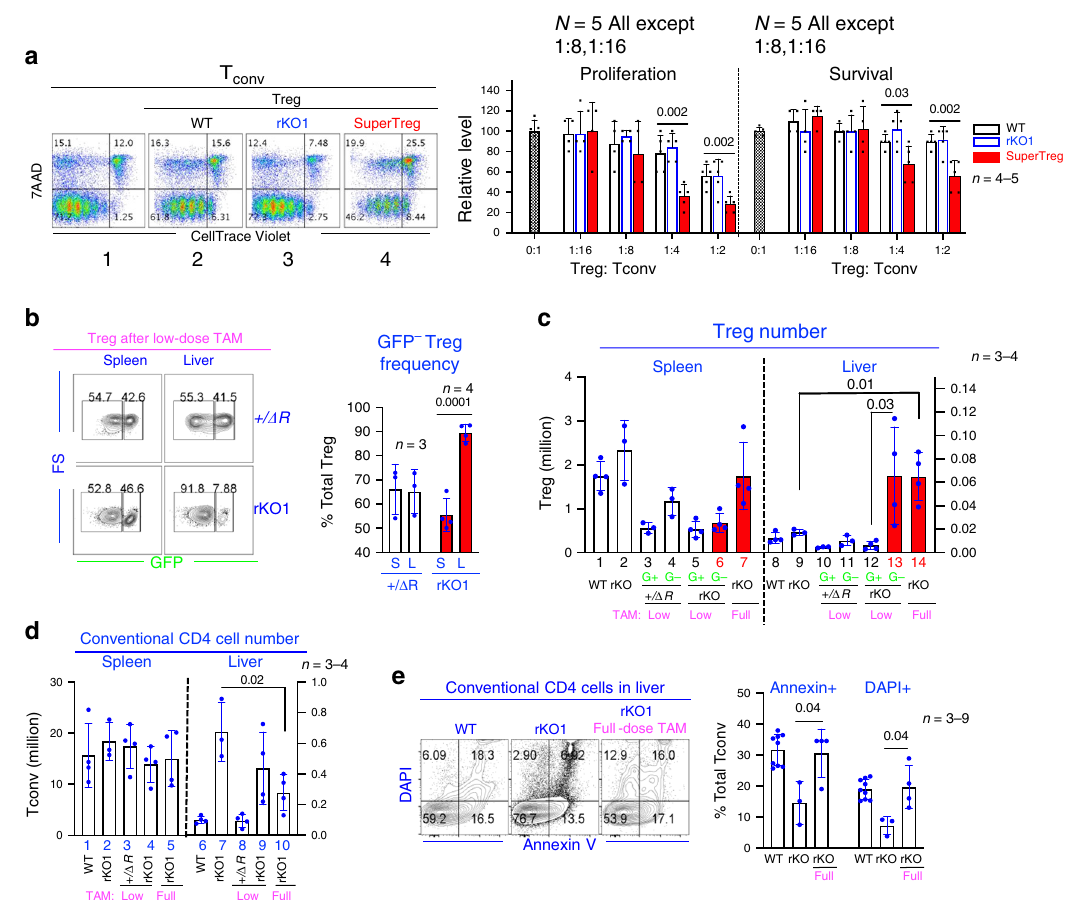
Fig. 5 SuperTreg cell function in vitro and in vivo. a SuperTreg suppression in vitro. Conventional CD4 cells (Tconv), labeled with CellTracer, were stimulated with APC and anti-CD3 in the presence or absence of Tregs for 5 days before analyzing 7-AAD and CellTracer fl uorescence. Representative FACS plots were shown at the left (Treg:Tconv = 1:4). The inverse of CellTracer MFIin total Tconv and the proportions of viable (7-AAD − ) Tconv were taken as measures of Tconv proliferation and survival, respectively, which are displayed as the percentages of the control (Treg:Tconv = 0:1). n = 5 repeats for all the conditions, except 1:16 and 1:8 ( n = 4); the data are pooled from four independent experiments. b , c SuperTreg accumulation in the liver. rKO1 mice were treated with TAM and analyzed 7 days later for Treg frequency ( b ) and number ( c ) in the spleen (S) and liver (L). In b low-dose TAM was used, leading to GFP loss in only a fraction of Tregs, as shown in the FACS plot and summarized in the bar graph. + / Δ R controls were Brg1 + / Δ R ;FoxP3 YFP − Cre ; R26 CAG-FlpoER . “ WT ” mice included + / Δ R and + / F mice as mentioned in Fig. 2a legend. G + and G − , GFP + and GFP − Treg subsets, respectively. In c n = 4 for all mice, except rKO and + /DR ( n = 3). d , e The number ( d ) and death ( e ) of conventional CD4 cells. The bar graph in e summarizes total Annexin + and total DAPI + conventional CD4 cells. Mice were described in b , c except that fi ve more WT data points were pooled. In d n = 4 for all mice, except rKO1 ( n = 3); in e n = 9 ( WT ), 3 ( rKO ), or 4 ( rKO